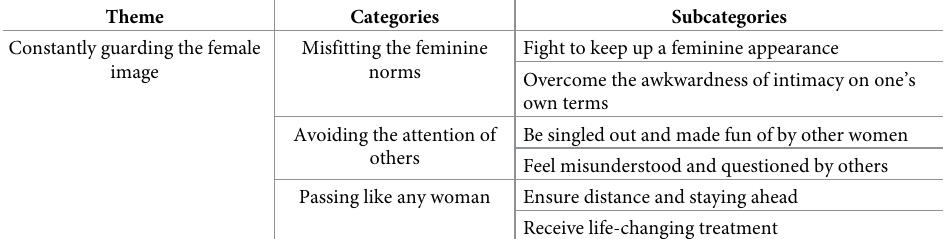
Table 3. Theme, categories and subcategories for women with primary